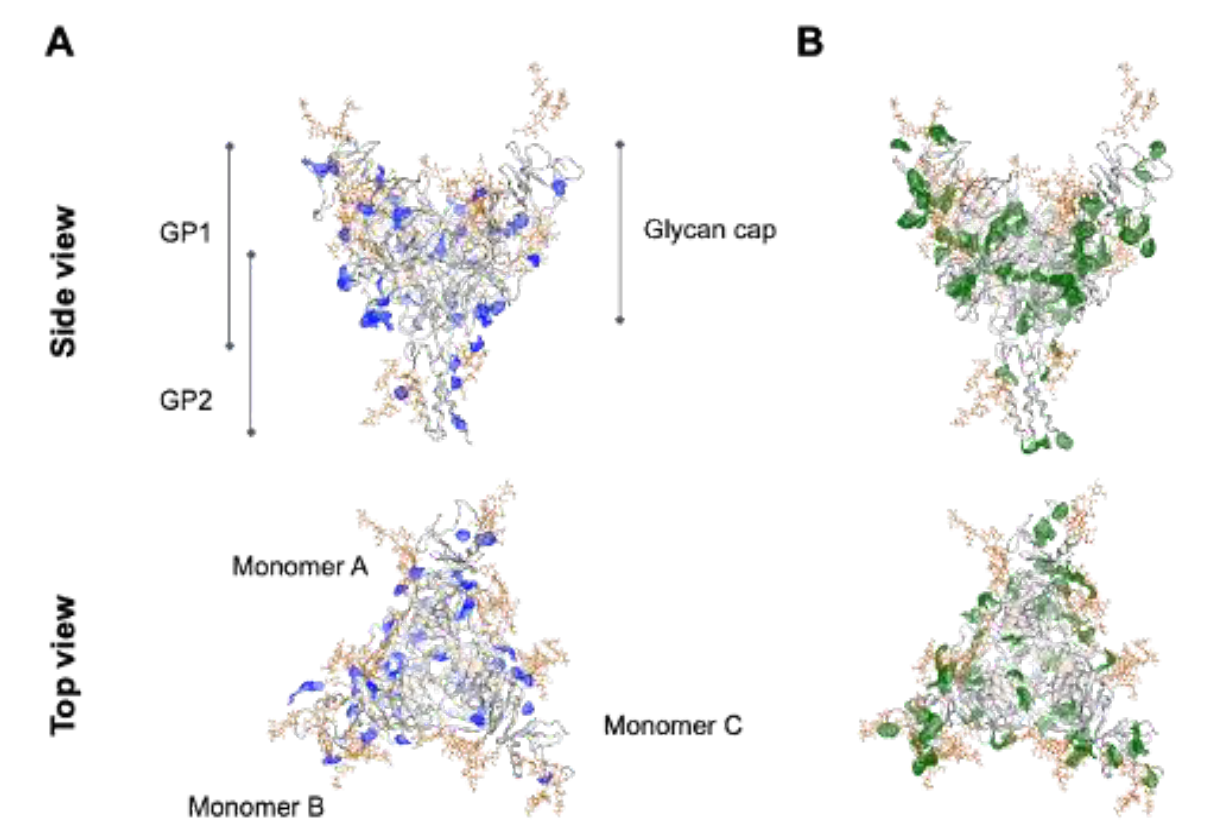
Figure 7. Characterization of chemical features of the Ebola virus glycoprotein surface for the molecular interactions. An Ebola virus GP ∆ -Res structure at 100 ns of MD simulations was used to characterize the chemical features of the protein surfaces for molecular interactions using the Protein Patch Analyzer tool in MOE [56–60]. This program calculates electrostatic or hydrophobic patches on the protein to elucidate the 3D distributions of interaction-prone areas. ( A ) Molecular patches relevant to electrostatic interactions. Blue portions in the GP ∆ -Res structure indicate the positively charged patches with a minimum area of 40 Å 2 that potentially interact with negatively charged molecules. ( B ) Molecular patches relevant to hydrophobic interactions. Green portions indicate the hydrophobic patches with a minimum area of 50 Å 2 that were potentially involved in the interactions with the hydrophobic moieties of molecules.